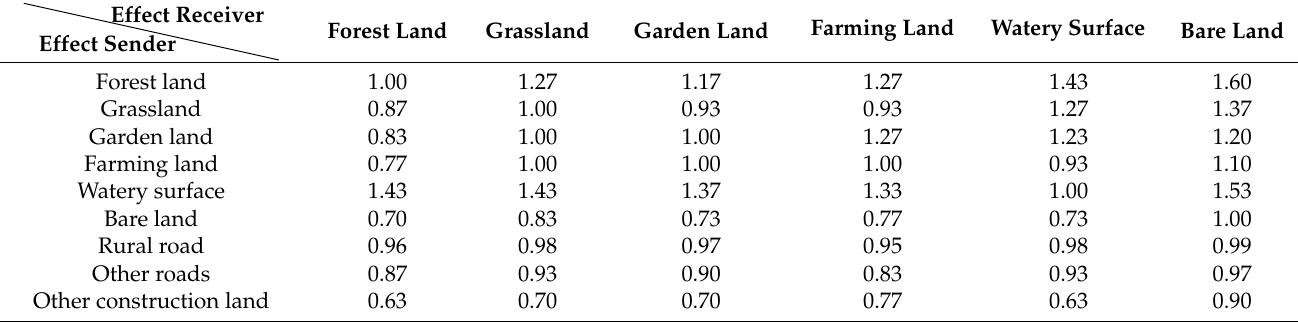
Table 3. Influencing intensity of the neighboring